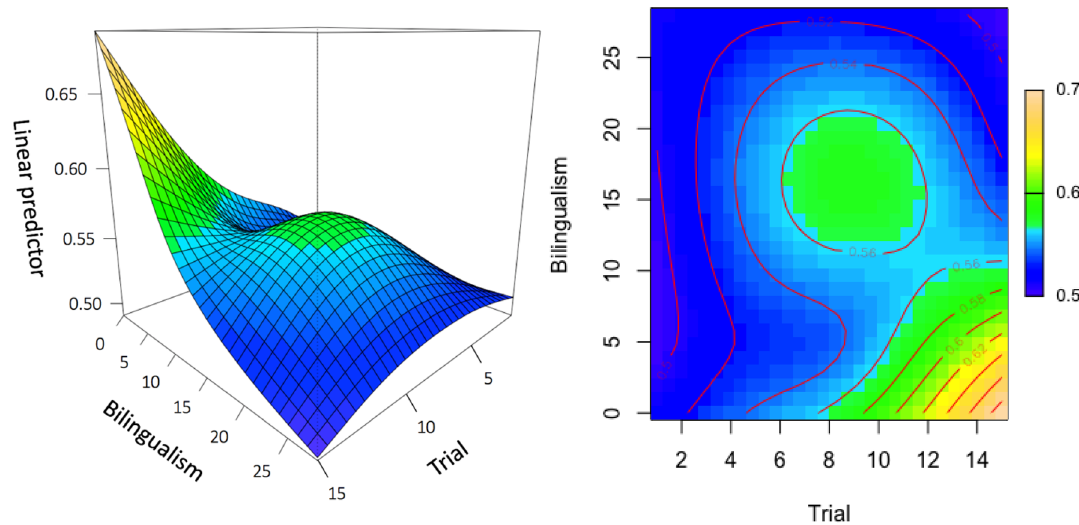
Figure 4. Proportion of looking to the changing stimulus (the outcome variable) rises rapidly during the final trials of the experiment for individuals who had learned their second language shortly after learning their first language—but not for individuals who had learned their second language later in life. ‘Bilingualism’ was calculated by subtracting age of first language acquisition from age of second language acquisition (in years); scores close to zero represent bilinguals who acquired their second language shortly after their first language (‘early bilinguals’), scores far from zero represent bilinguals who acquired their second language later in life (‘late